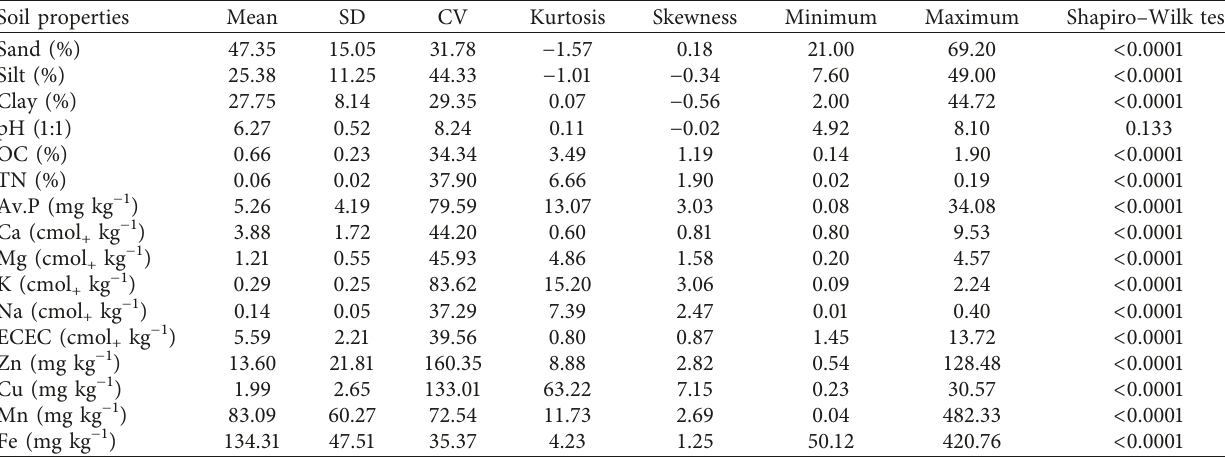
Table 1: Descriptive statistics of soil